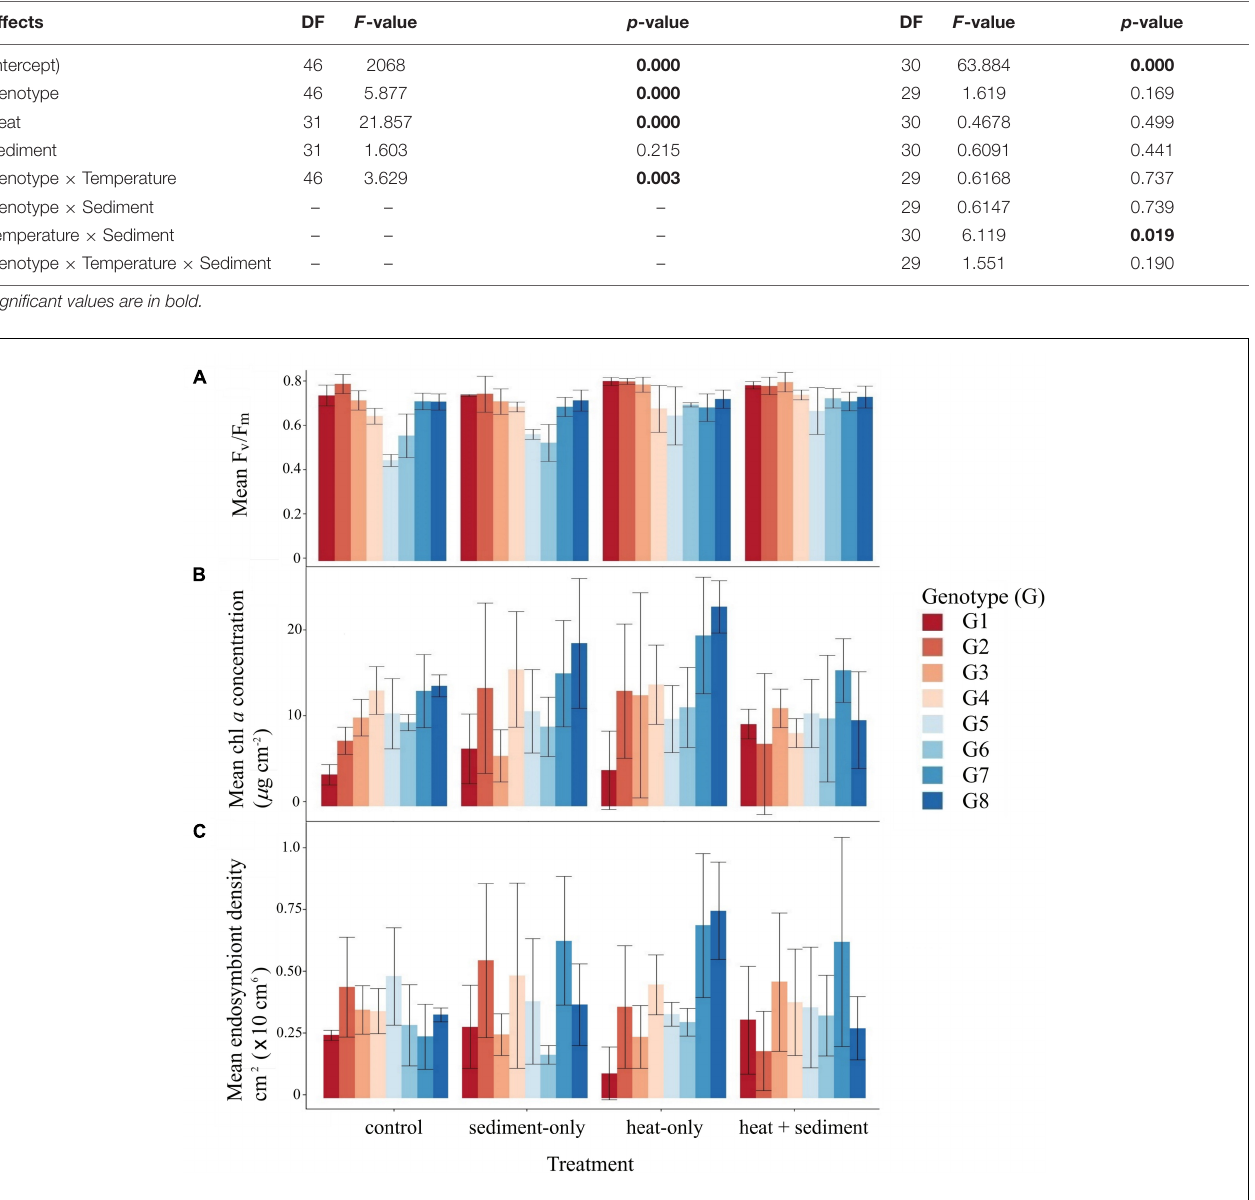
Frontiers in Marine Science |